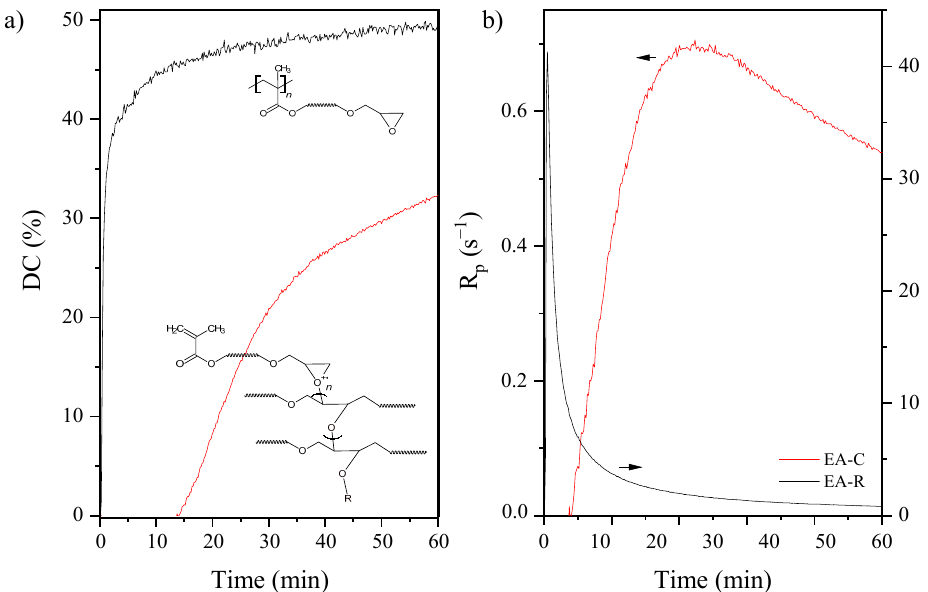
Figure 8. The epoxy and unsaturated double bond conversion ( a ) and the photopolymerization rate ( b ) curves of the EA under the different mechanisms of polymerization: C–cationic or R–radical (RT-IR method; mercury UV lamp, 280–400 nm, 10 mW/cm 2 ; composition of the photoreactive formulations: 96 wt% of EA prepolymer, 4 wt% of cationic or radical PI).